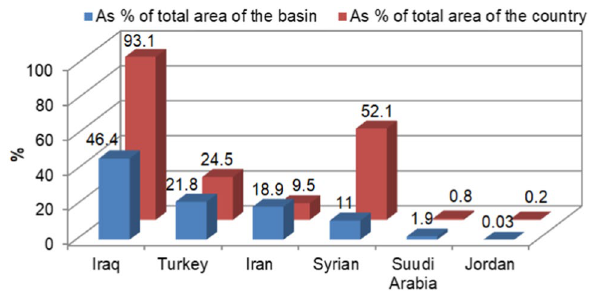
Fig. 1 The riparian countries in the ETRB (FAO 2009)